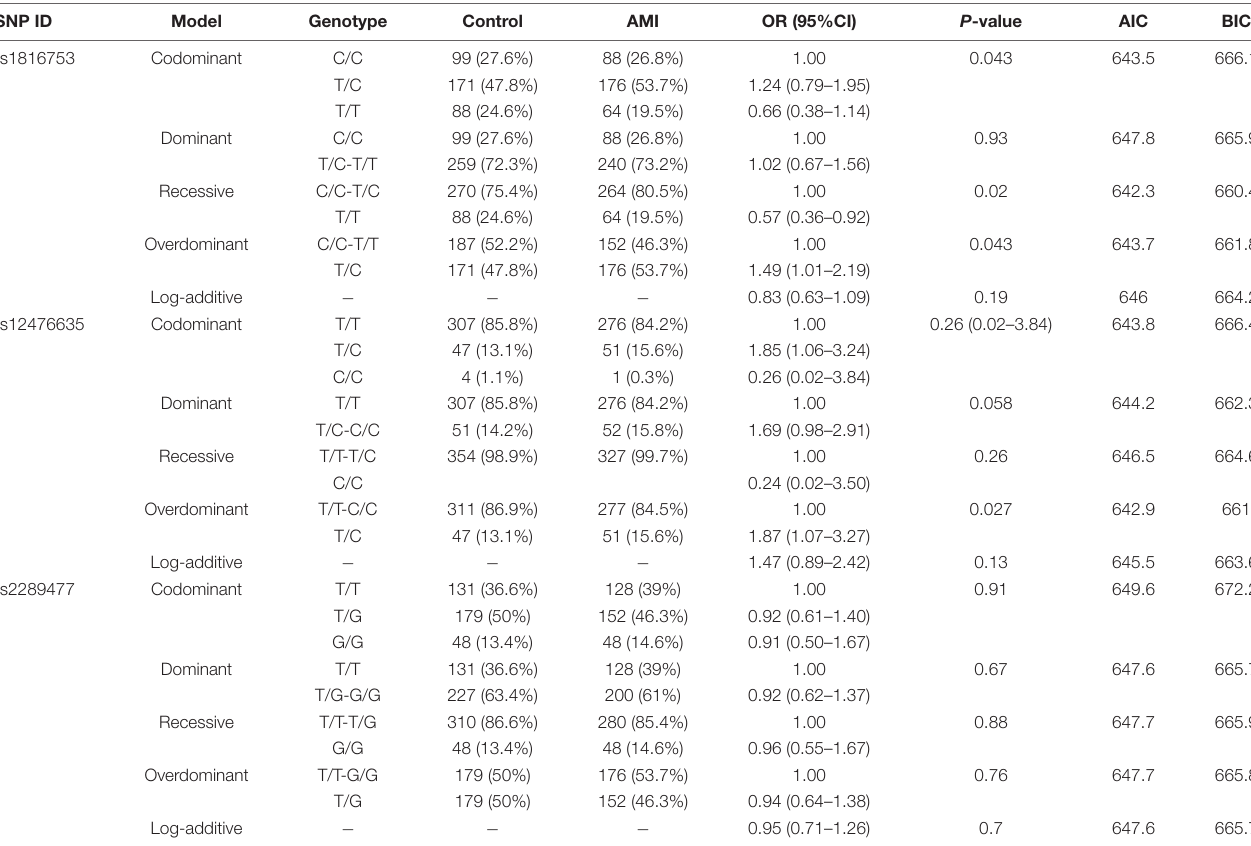
TABLE 6 | Genetic models’ analysis of the association between the SNPs in the ATG16L1 promoter region and AMI (adjusted by SEX + AGE). SNP ID